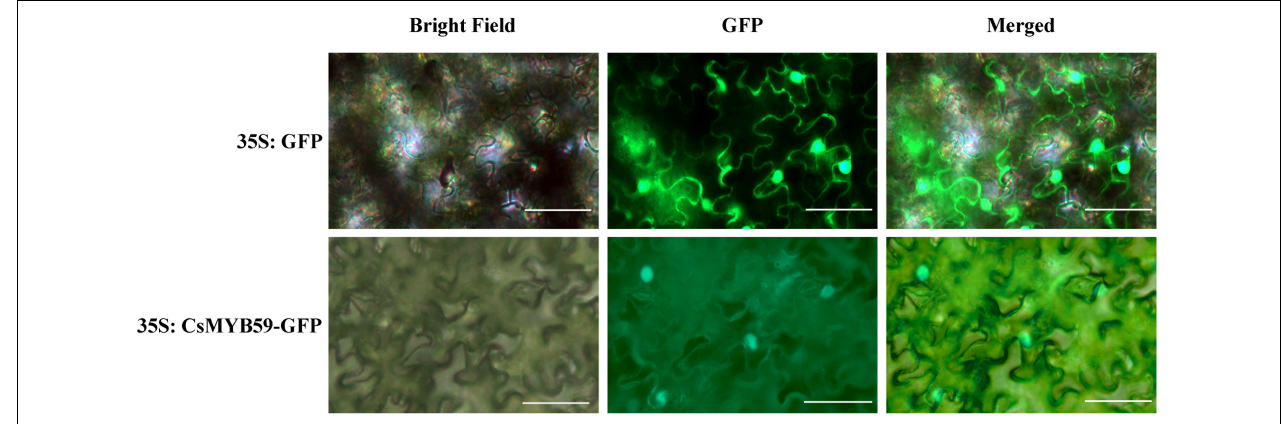
FIGURE 3 | Subcellular localization analysis of CsMYB59 protein. The GFP- and CsMYB59-GFP-fused proteins were transfected into the epidermal cells in Nicotiana benthamiana leaves. The white bars represent 50 µ m. GFP, green fluorescent protein.